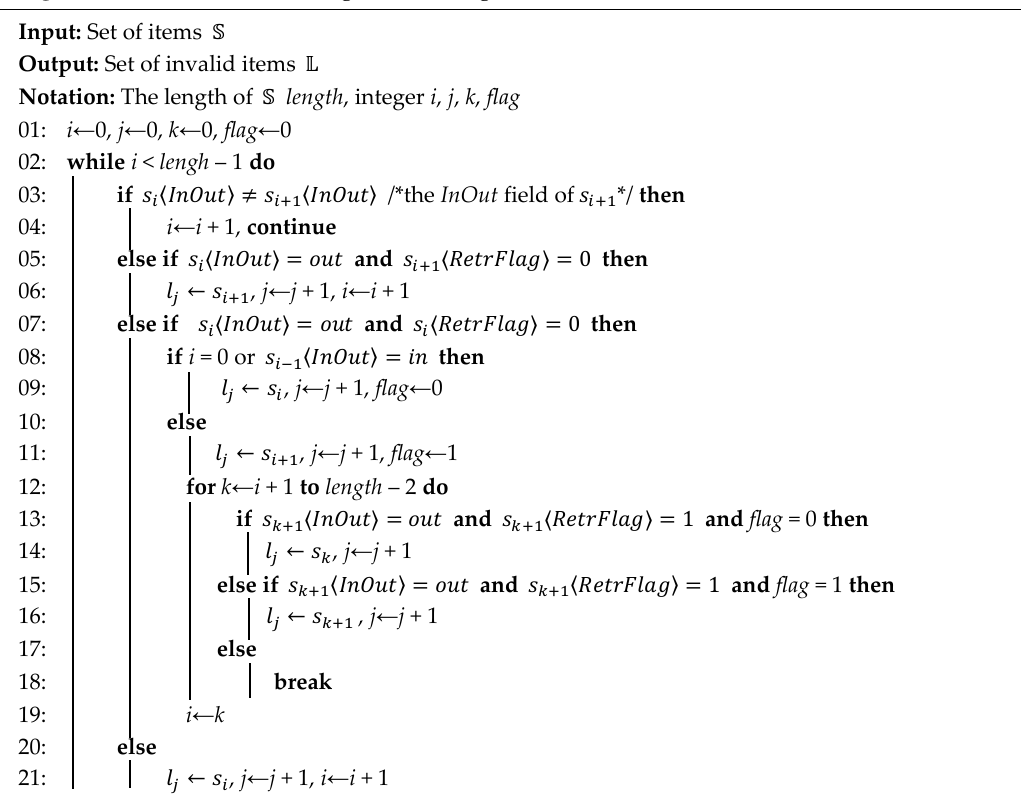
window algorithm. Algorithm 1: two-sized sliding window algorithm Algorithm 1: two-sized sliding window algorithm Algorithm 1: two-sized sliding window algorithm